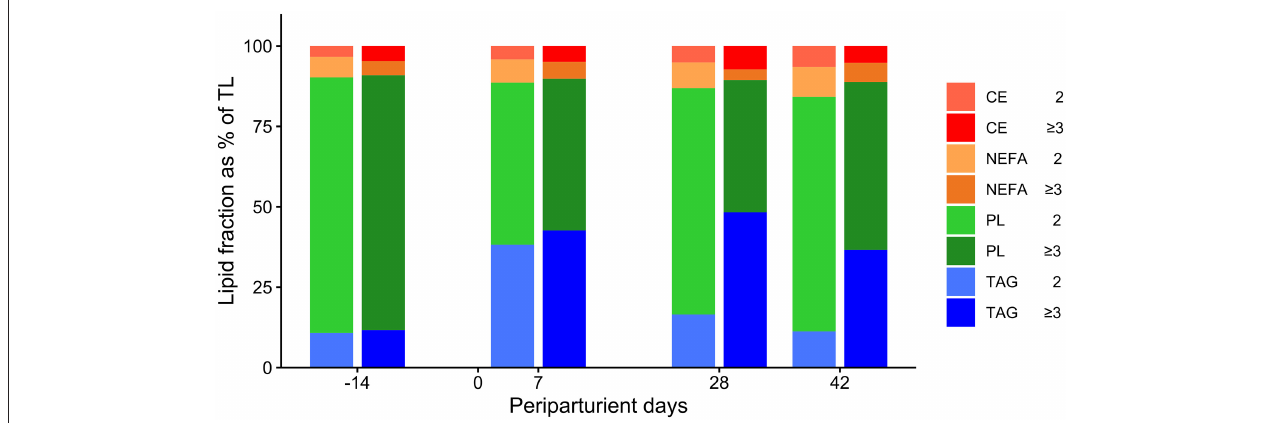
FIGURE 2 | Percentage distribution of triacylglycerol (TAG), phospholipids (PL), non-esterified fatty acids (NEFA), and cholesterol esters (CE) of the total lipid content in liver tissue in German Holstein cows of groups Lact2 (lactation 2, n = 3) and Lact ≥ 3 (lactation 3 or greater, n = 5) in the transition period [ − 14 = d 14 antepartum (a.p.); 0 = parturition; 7, 28, 42 = d 7, d 28, d 42 postpartum (p.p.)]. Significances between sampling days within groups ( P -values F-test): TAG: Lact2: P = 0.07 , Lact ≥ 3: P = 0.21 ; PL: Lact2: P = 0.04 , Lact ≥ 3: P < 0.01 ; NEFA: Lact2: P = 0.48 , Lact ≥ 3: P = 0.10 ; CE: Lact2: P = 0.11 , Lact ≥ 3: P = 0.14